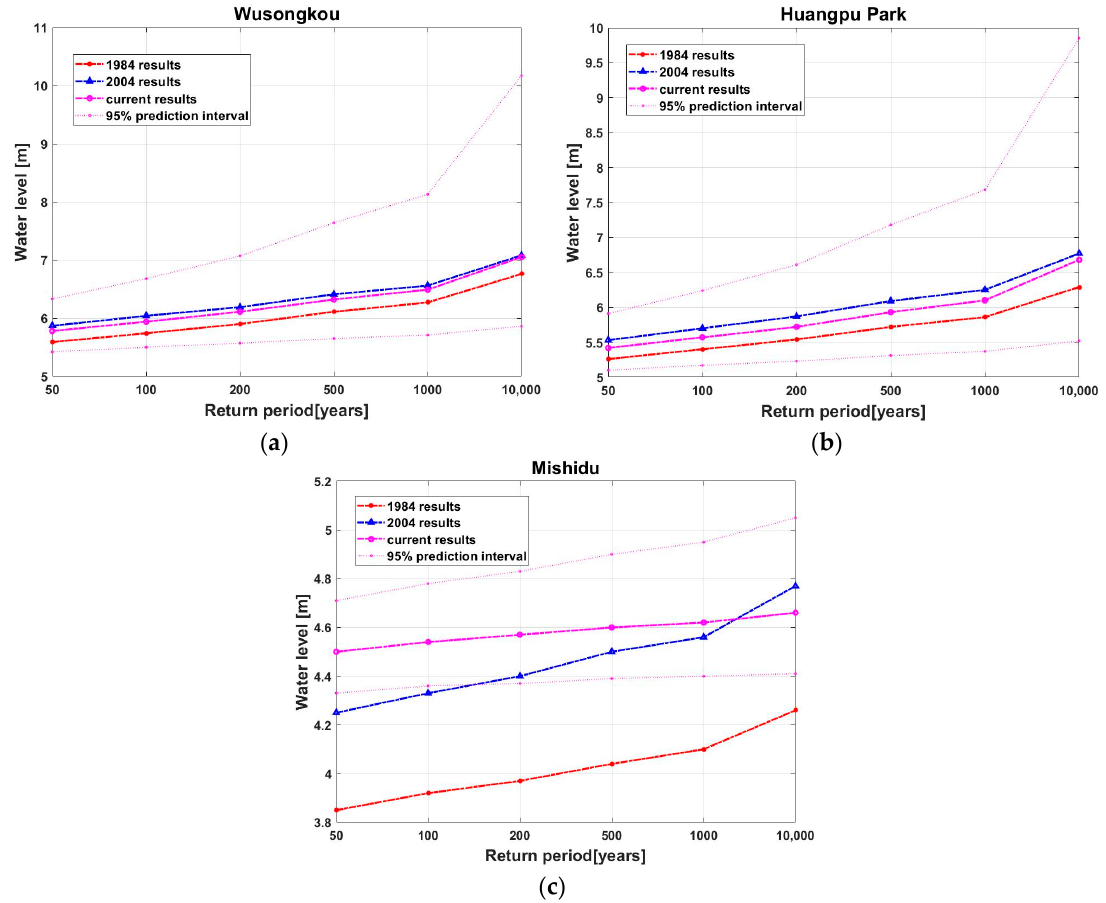
Figure 7. Comparison of water levels in the current research as a function of return periods at Wusongkou ( a ), Huangpu Park ( b ) and Mishidu ( c ), to the previous studies [7,8] (with 95% prediction interval).